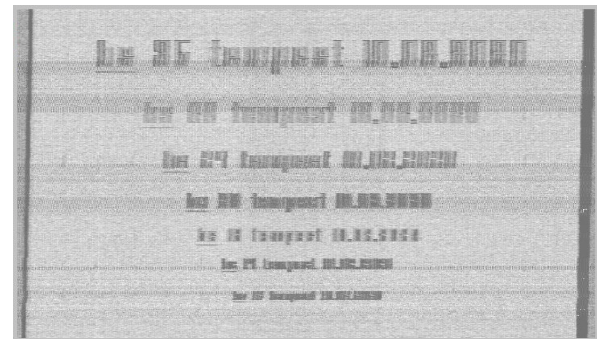
Figure 9. Image recovered when secure symmetrical font was displayed—R&S FSET receiver.